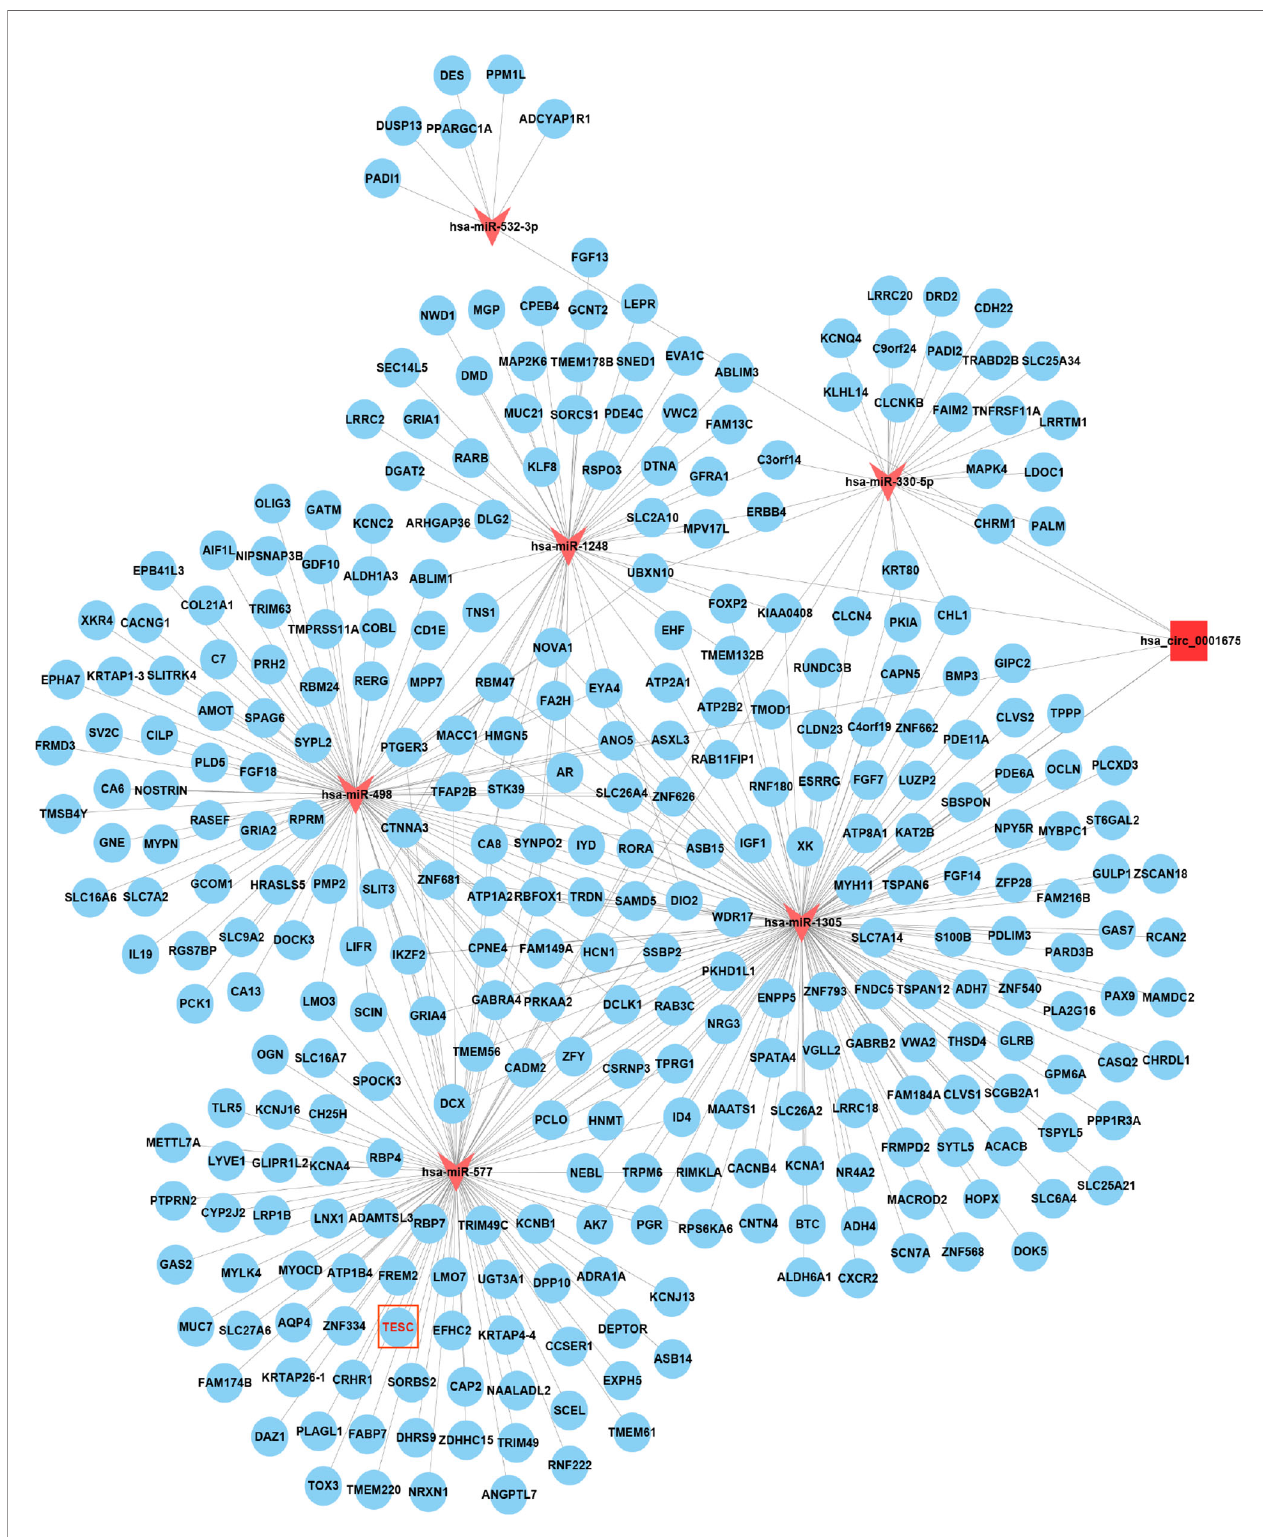
FIGURE 6 | Cytoscape showed that hsa_circ_0001675 was closely related to six miRNAs, hsa-miR-330-5p, hsa-miR-498, hsa-miR-532-3p, hsa-miR-577, hsa- miR-1248, and hsa-miR-1305, and 411 mRNAs.